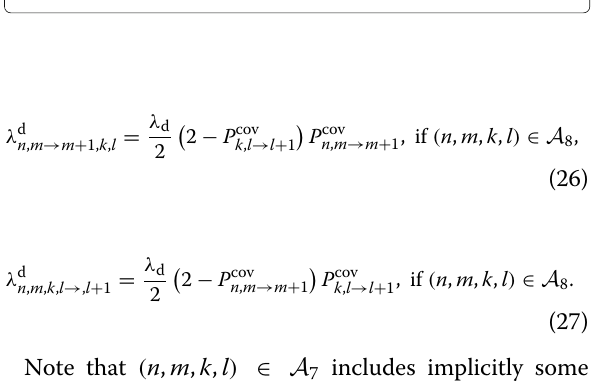
Fig. 4 Examples of the allowed states of the 4D M/M/m/m Markov